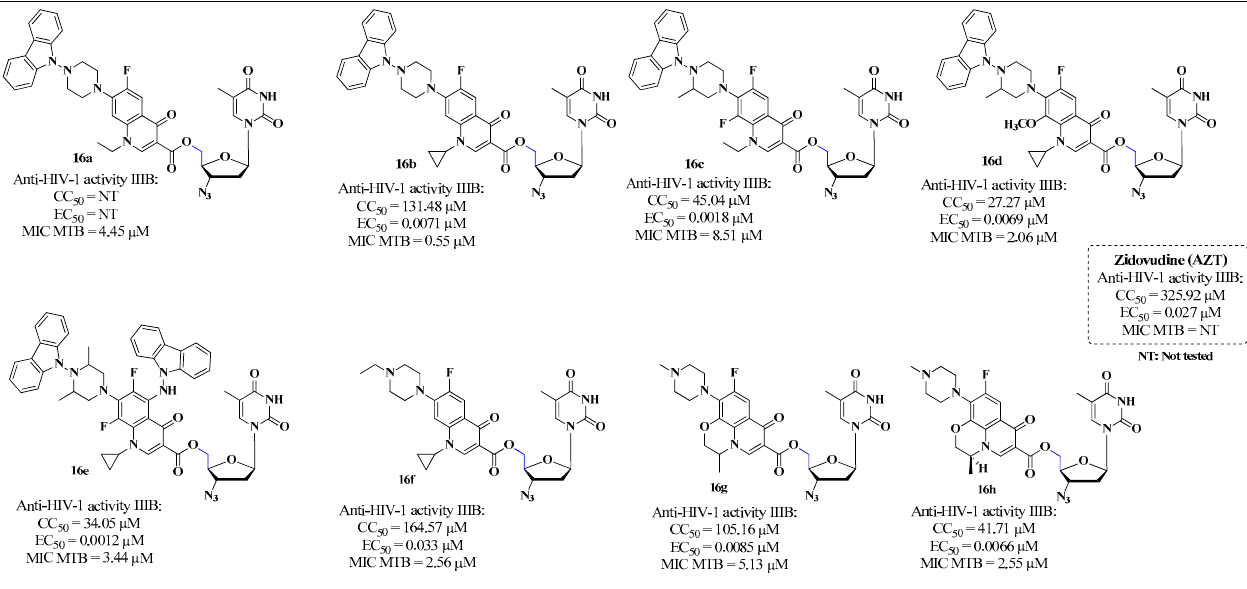
Figure 15. Biological activities (anti-HIV cells: MT-4/anti-MTB cells: H 37 Rv) of the derivatives 16a – h synthesized by Senthilkumar and collaborators in 2009 [94].